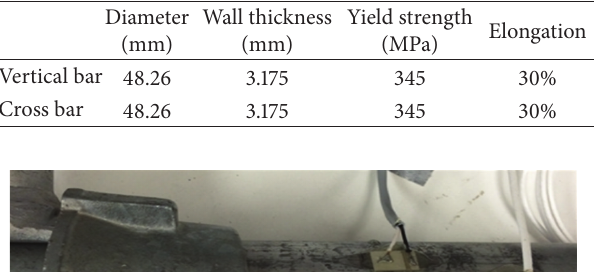
Table 2: Cuplock Scaffold model features.